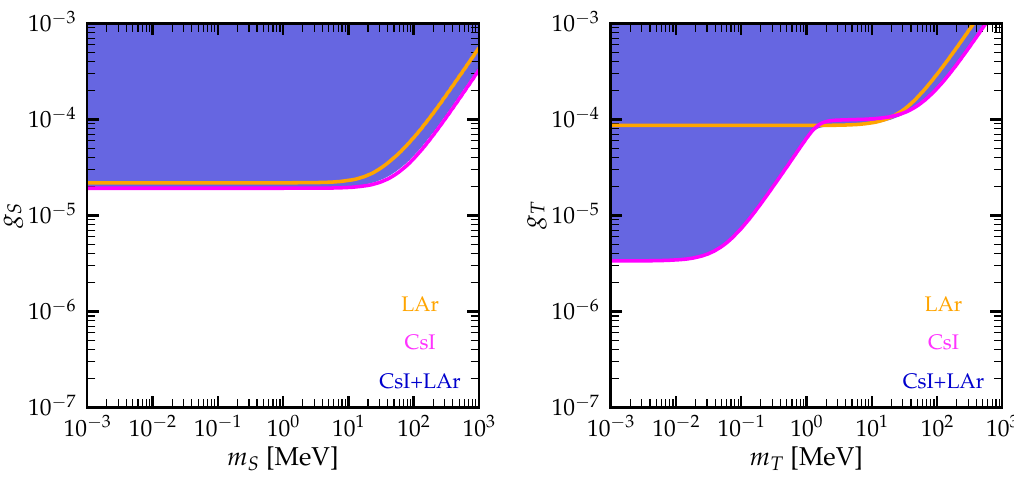
Figure 9 . 90% C.L. (2 d.o.f.) exclusion regions from the analysis of CsI (magenta), LAr (orange) and CsI + LAr (blue) data, for the universal light scalar model (left) and the universal light tensor model (right). The analysis of CsI data includes CE ν NS + ES